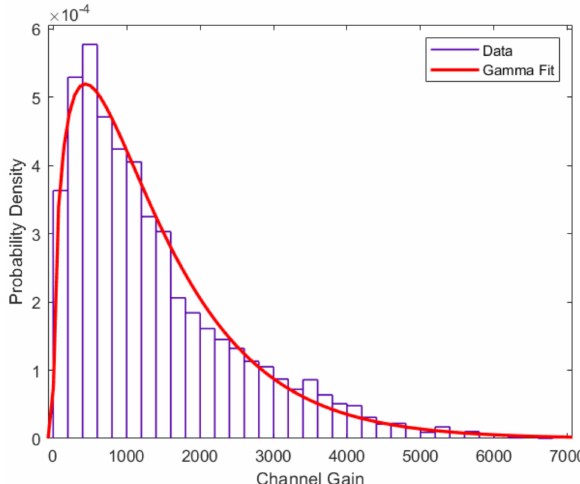
Figure 4. Channel gain fit into a gamma distribution for MTs uniformly distributed on a 2D plane and having a single element antenna